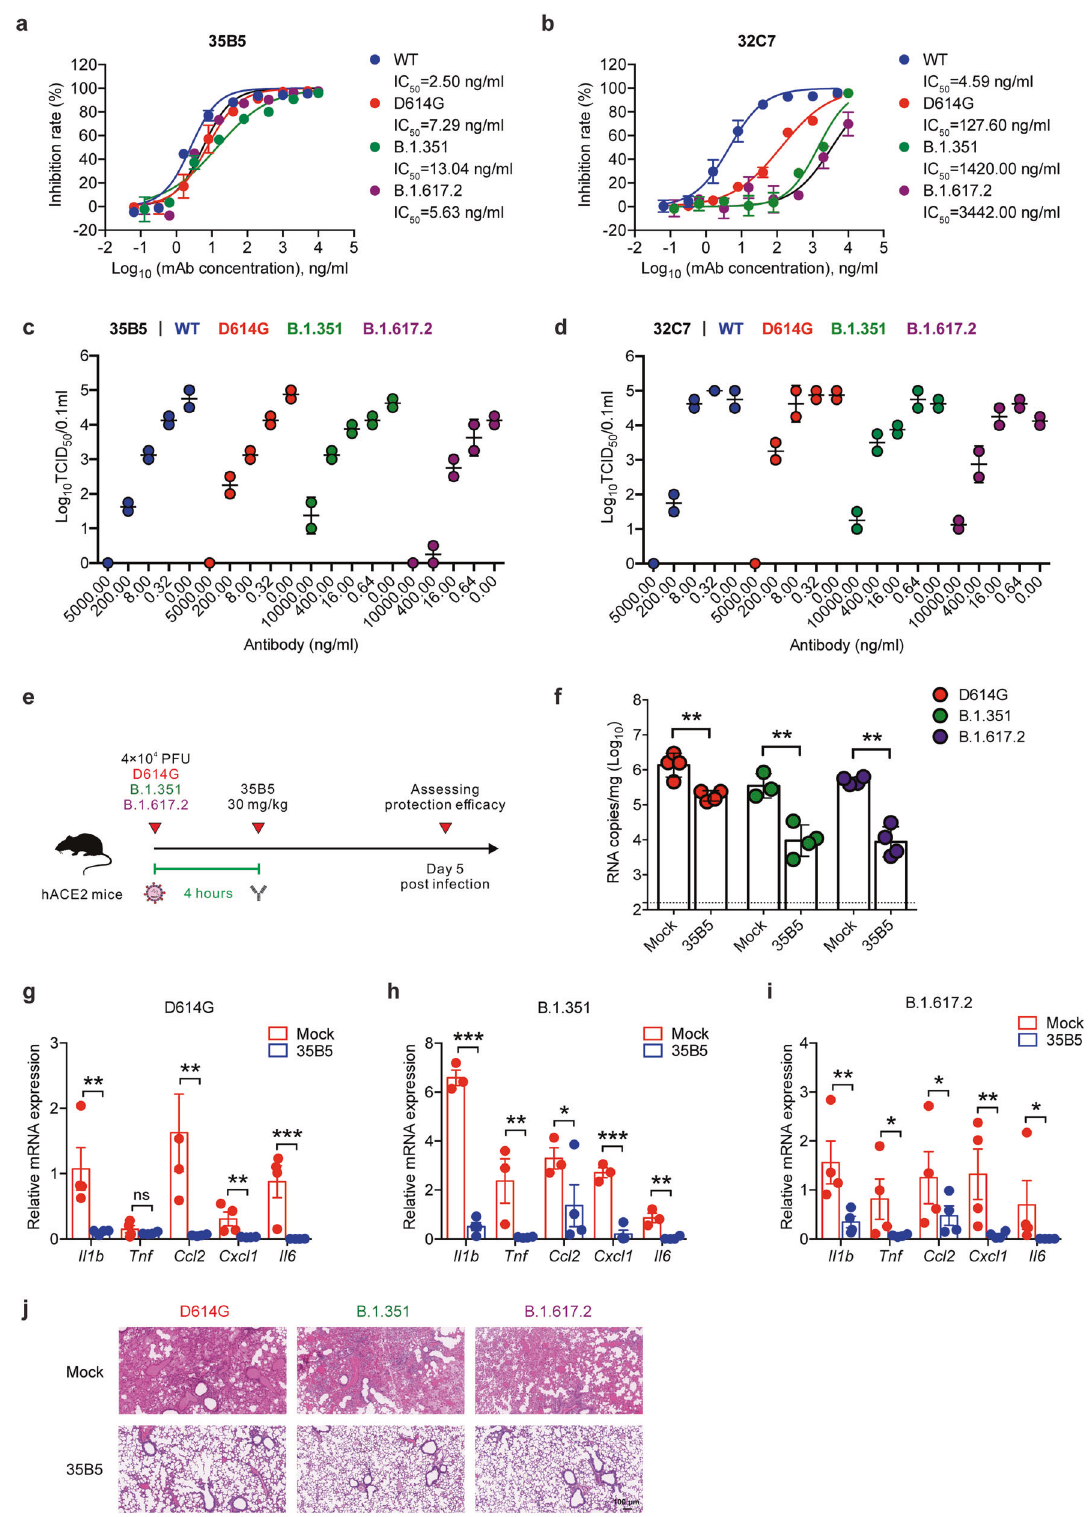
ectodomain trimer structure of the spike S-HexaPro protein (S-6P), 27 a more stable spike variant containing four additional proline substitutions (F817P, A892P, A899P, and A942P) from S-2P (Supplementary Fig. 2), suggesting that 35B5 harbors the potent dissociation activity toward the spike protein. Nonetheless, a few